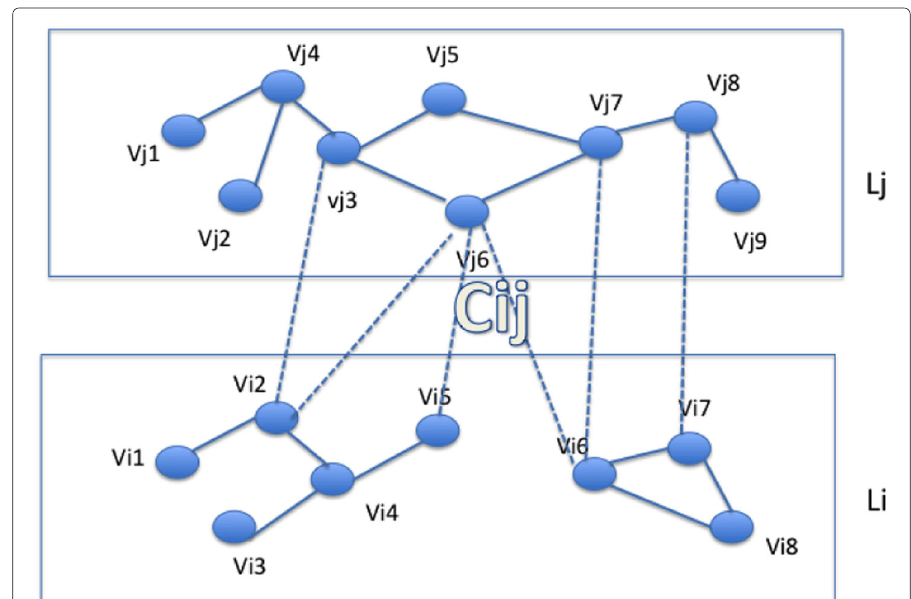
Fig. 1 Example of a 2-layers